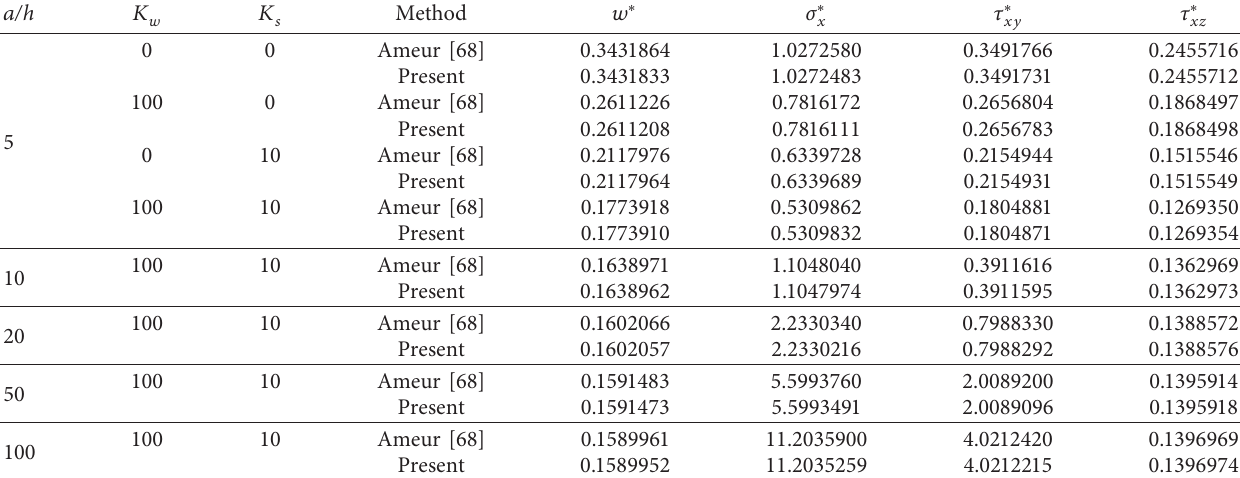
Table 2: The deflections and stresses of the square FGM plates with different values of the side-to-thickness ratio.